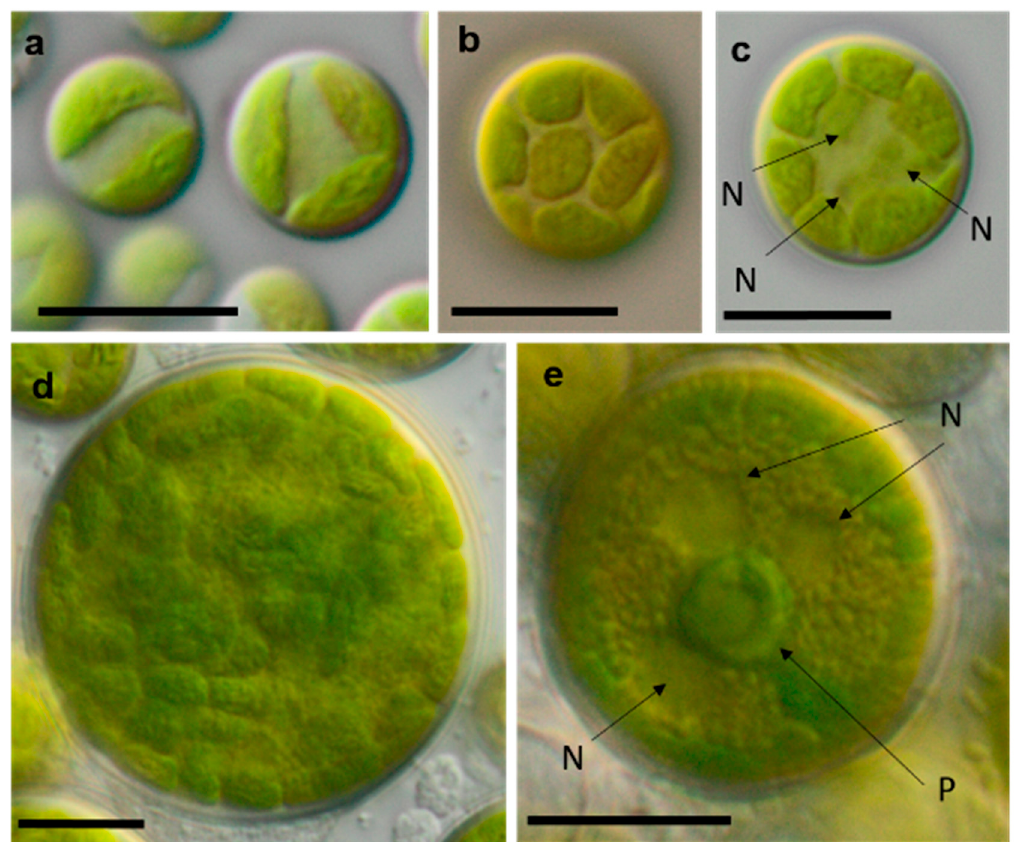
Figure 17. Photomicrographs of Sphaeropleales isolates. ( a – d ) Bracteacoccus minor ( a ) young cells, TTF-2-1-M and ( b , c ) TTF-2-1-A ( b ) surface view of disc-shaped chloroplasts; ( c ) several nuclei are visible in the cell; ( d ) mature cell with multiple chloroplasts, NN-4-1-CC, ( e ) and Tetradesmus cf. dissocuatus TT-3-1-G, a large mature cell before division containing several nuclei and a central pyrenoid. Arrow labels: N = nucleus and P = pyrenoid. Scale bars: 10 µm.